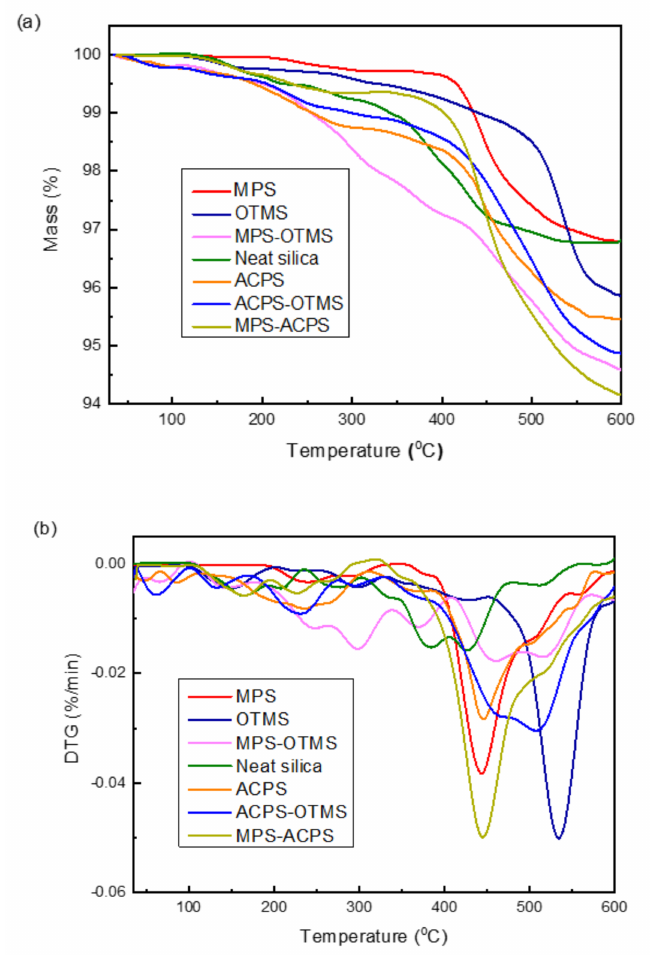
Figure 2. ( a ) TG comparative scans reflecting the different thermal stability of the tested silica nanopar- ticles; ( b ) DTG curves for neat and silica nanoparticles treated with different types of